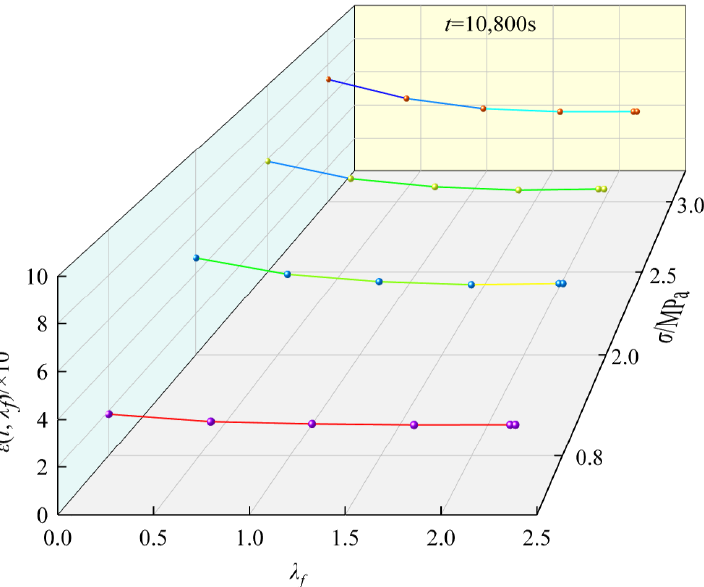
Figure 4. Relationship between creep strain and λ f .